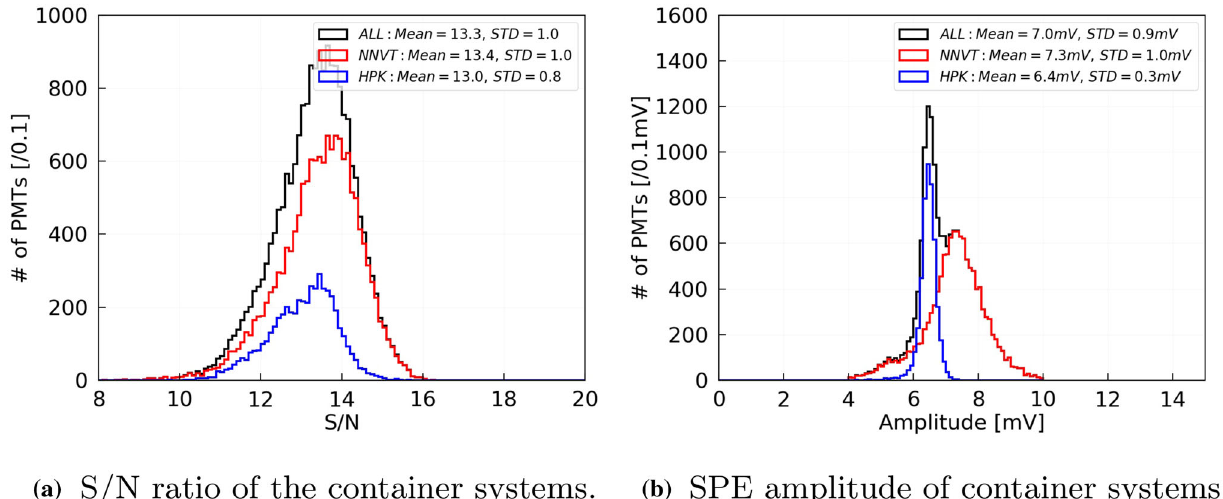
Fig. 14 The S/N ratio of all the measurements with qualified PMTs (left). The SPE amplitude of all qualified PMTs (right). Black: all PMTs; red: NNVT; blue: HPK. Note: the amplitude is only selected within [ 4 , 10 ]